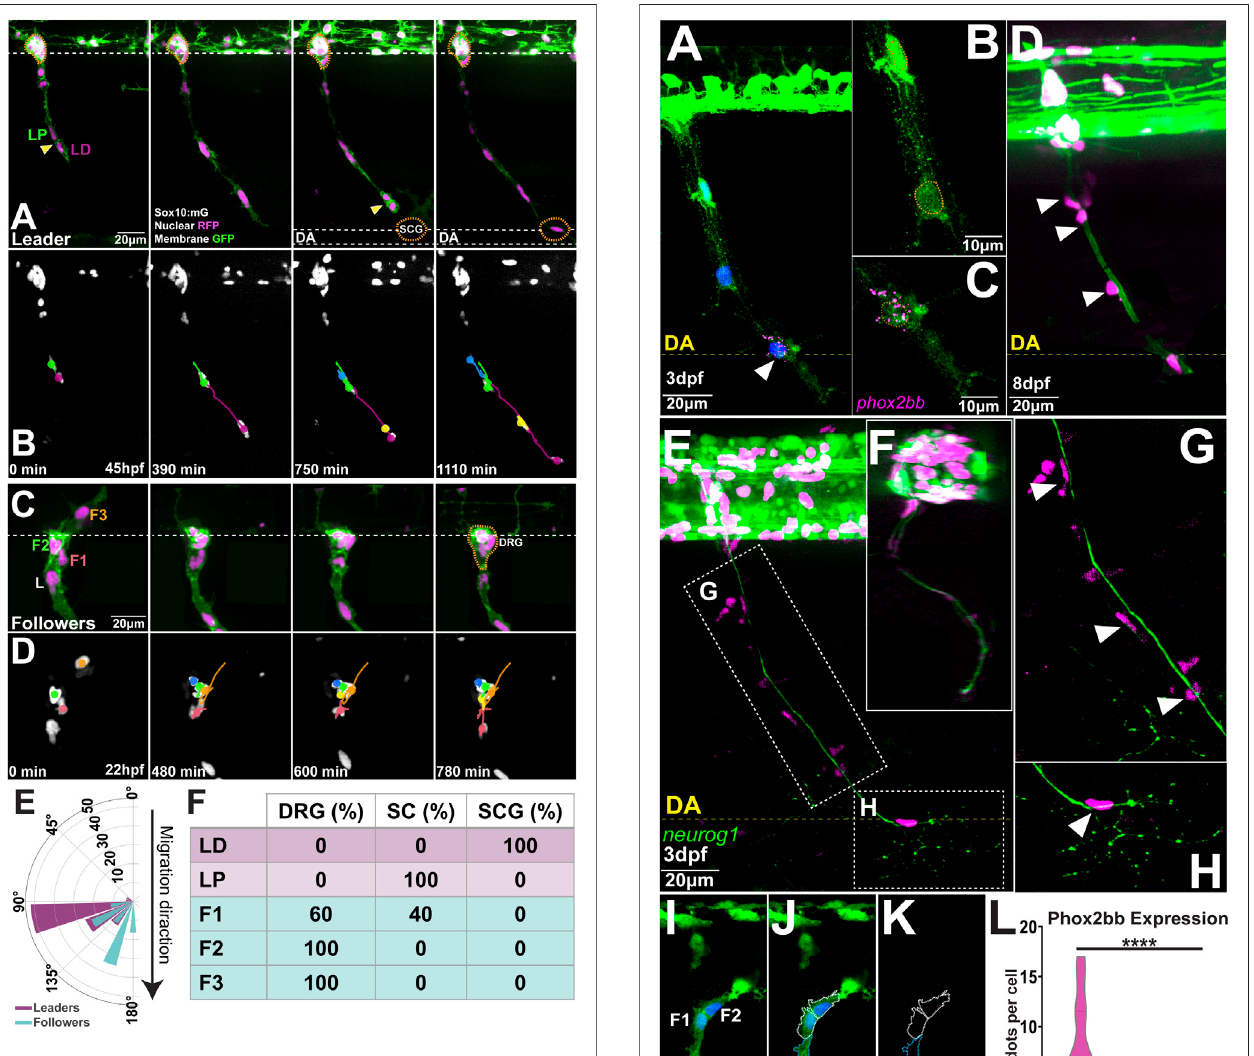
FIGURE 1 | Migratory position predicts differentiation outcome (A,B) Selected frames of (A) live imaging and (B) cell tracks starting at 45hpf of a Sox10:mG embryo at the level of somite 20 (C,D) Selected frames of (C) live imaging and (D) cell tracks of Sox10:mG between 22 and 35hpf at the level of somite 9. L: leader, F1: fi rst follower, F2: second follower, F3: third follower (E) Orientation of the division plane (leaders n = 27, followers n = 43) (F) Derivatives formed by each cell in the migratory chain (n = 14 chains). Anterior to the left, dorsal top. Yellow arrows indicate divisions; orange dotted line DRG and SCG positions. LD leader ’ s distal and LP leader ’ s proximal daughters. DRG: dorsal root ganglia; SCG: sympathetic chain ganglia; SC: Schwann cell. Time in minutes after the beginning of the movie.